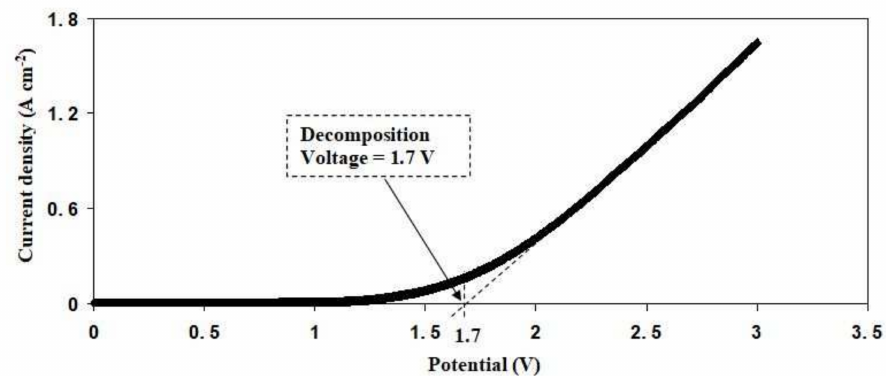
Figure 11. LSV curve for the SL4